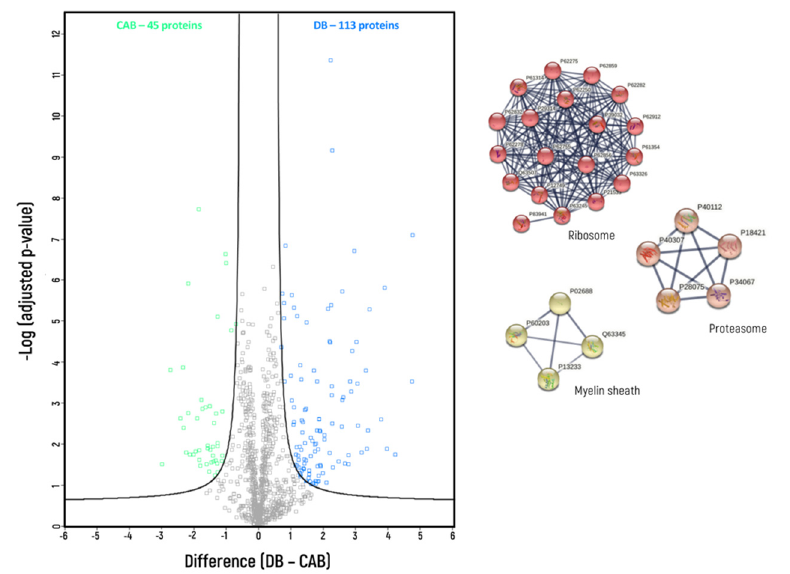
Figure 2. Volcano plot of proteins for which different levels were found between DB and CAB homogenization buffers (blue—overrepresented in DB buffer; green—overrepresented in CAB buffer); indicated are protein clusters which were identified by GO analysis with application of Markov clustering method (FDR < 0.01).